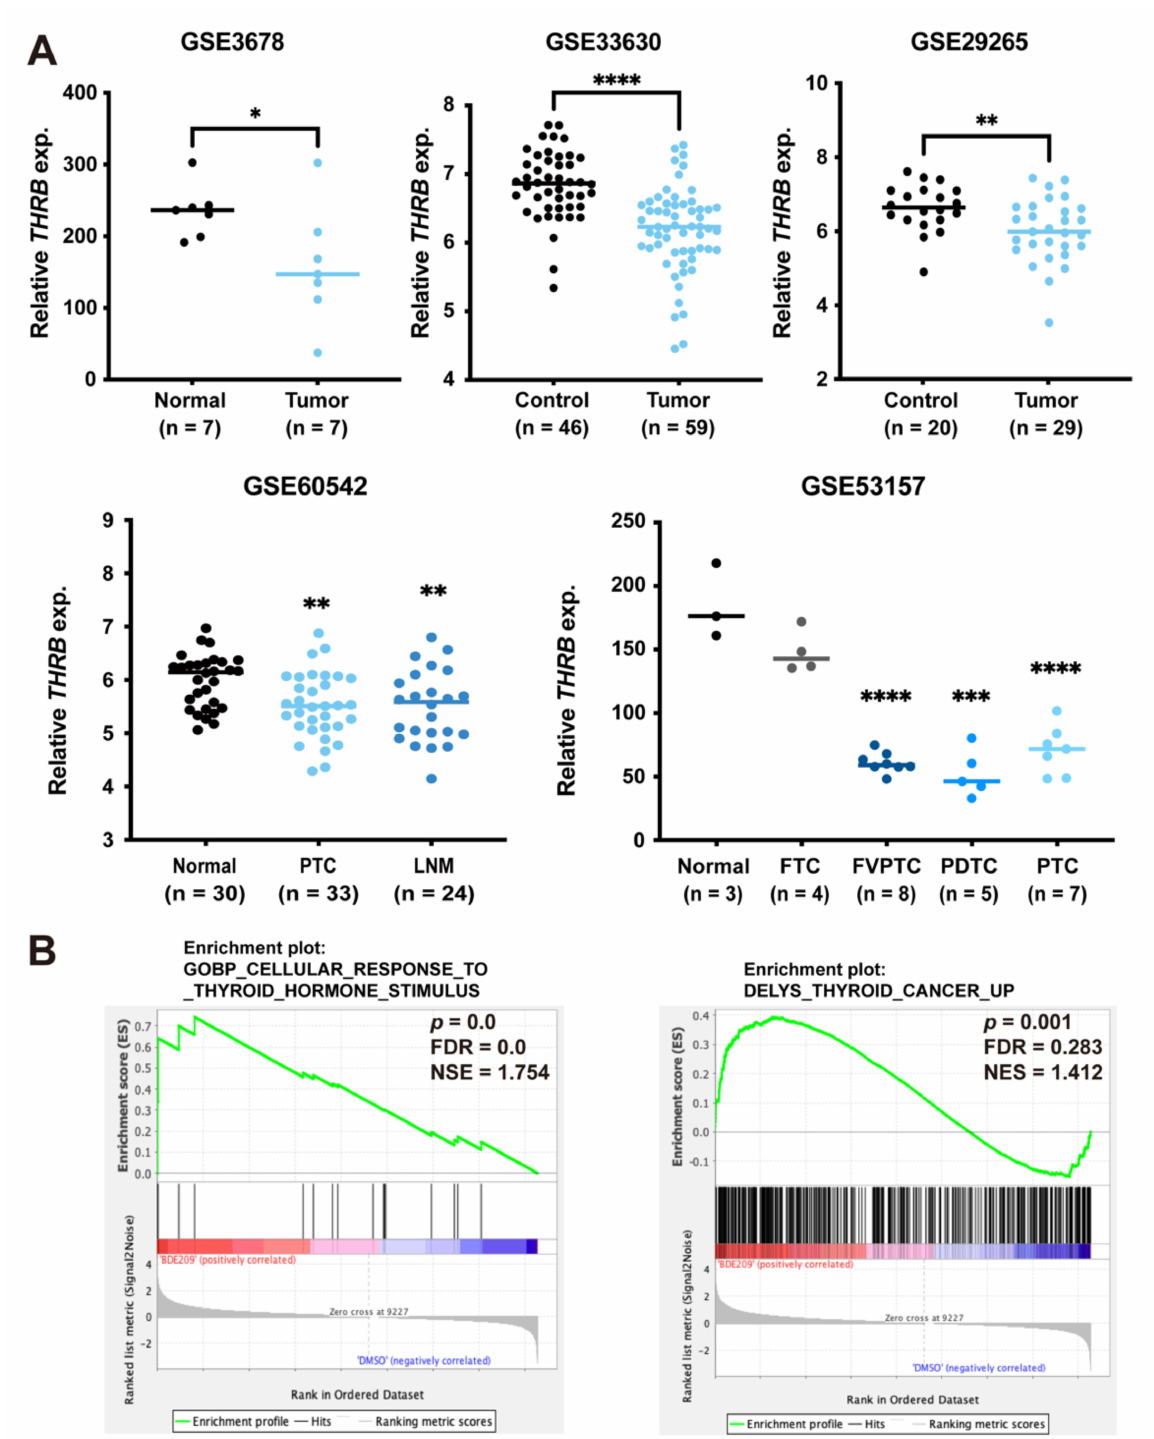
Figure 5. Inverse association between TRß expression and thyroid cancer. ( A ) Relationship between THRB and clinical outcomes. Thyroid tumours in GSE3678, GSE33630, GSE29265 and GSE60542 were analysed. * p < 0.05, ** p < 0.01, *** p < 0.001 and **** p < 0.0001. PTC, papillary thyroid carcinoma; LNM, lymph node metastasis; FTC, follicular thyroid carcinoma; FVPTC, follicular variant papillary thyroid carcinoma; PDTC, poorly differentiated thyroid carcinoma. ( B ) The enrichment of the indicated gene sets by